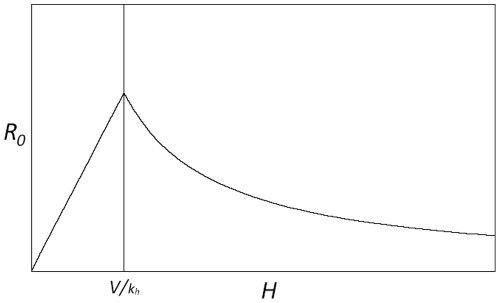
The response of R0 to varying population size of host individuals (H) in a single-host system.Note that R0 approaches zero for very small or very large values of H. The graph shows a discontinuity at the maximum level of R0 at